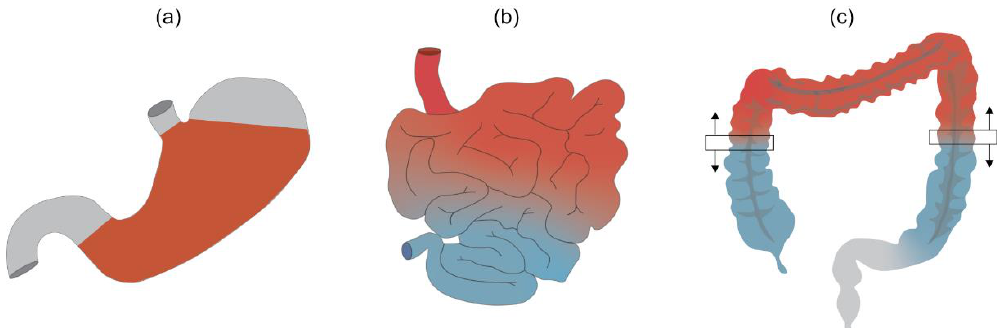
Figure 2. Spatial variation of dominant slow wave (SW) frequencies in the stomach, small intestine, and colon in healthy humans. ( a ) The SW frequency is approximately 3 cpm (red) and uniform across the stomach. ( b ) The small intestine has temporally and spatially dynamic SW patterns where the frequency decreases in a stepwise fashion aborally from approximately 12 cpm (red) in the duodenum to 8 cpm (blue) in the distal ileum. ( c ) Two types of SW rhythms coexist throughout the colon. In the proximal and distal colon, low-frequency activity (2–9 cpm, blue) dominates, while high-frequency activity (9–13 cpm, red) is more prevalent between these regions. The relative size of these zones is variable between subjects.